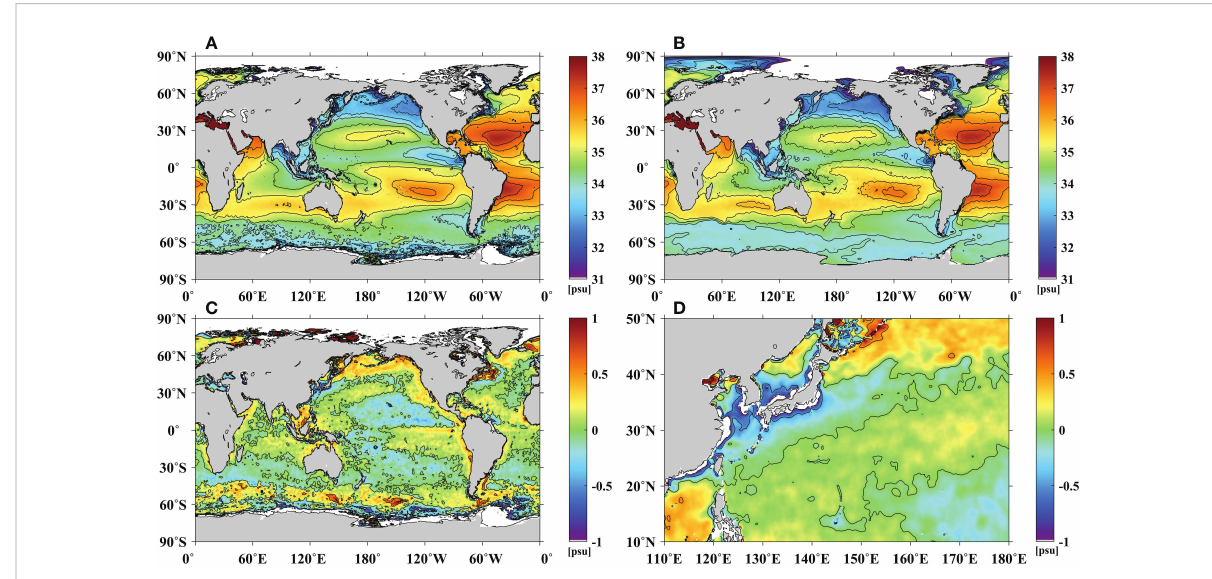
FIGURE 1 Spatial distributions of (A) Soil Moisture Active Passive (SMAP) satellite sea surface salinity (SSS) averaged over the period of 2015 to 2020, (B) mean SSS from World Ocean Atlas (WOA) 2018 over the period of 2005 – 2017, (C) differences between the SMAP and WOA salinity in the global ocean, and (D) enlarged portion of salinity differences in the Northwest Paci fi c from (C)